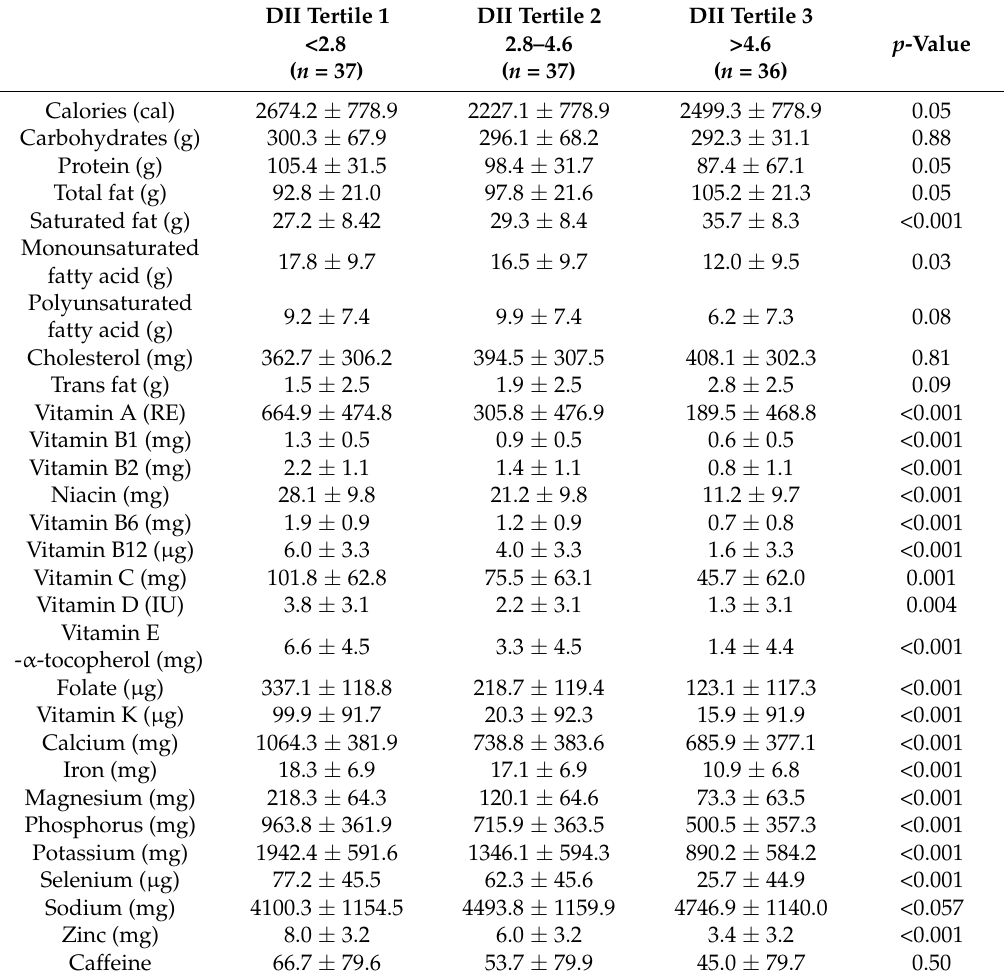
Table 2. Nutrient intake of participants by DII tertiles.